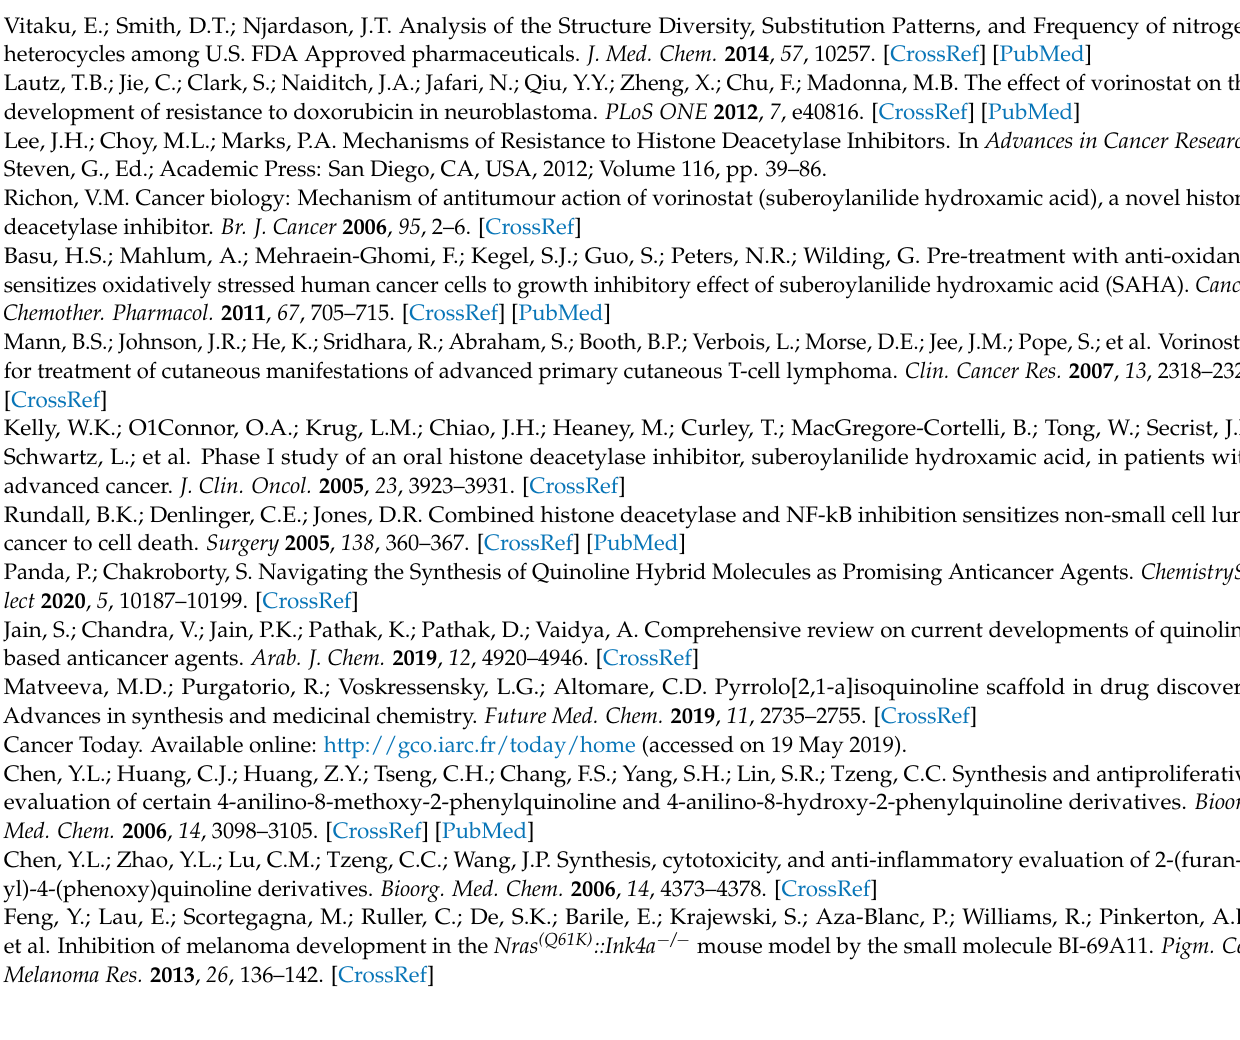
spectrum of compound 8a . Figure S11: 1 H-NMR spectrum of compound 8b . Figure S12: 13 C-NMR spectrum of compound 8b . Figure S13: 1 H-NMR spectrum of compound 8c . Figure S14: 13 C-NMR spectrum of compound 8c . Figure S15: 1 H-NMR spectrum of compound 8d . Figure S16: 13 C-NMR spectrum of compound 8d